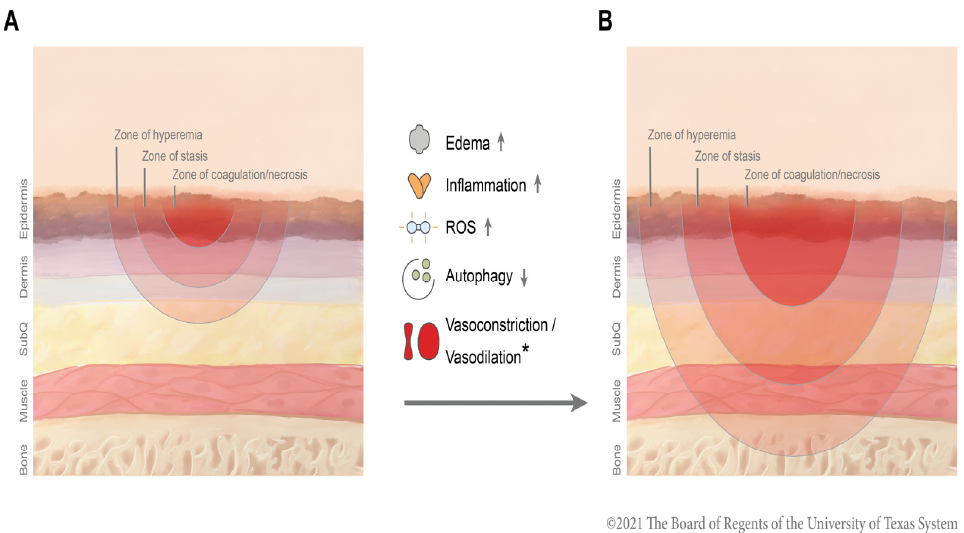
Figure 1. Mechanisms of burn wound conversion: Various mechanisms are involved in burn wound conversion from a second partial-thickness ( A ) to a full-thickness burn ( B ), including increased ROS generation, proinflammatory cytokines generation, increased edema, and reduced autophagy. * Due to contradictory data in the body of the literature, evidence for both increased and decreased wound perfusion exists, as discussed in this review.